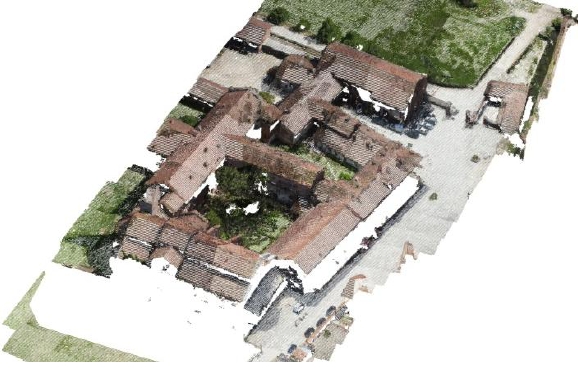
Figure 18. 3DModel processed with regular sampling method